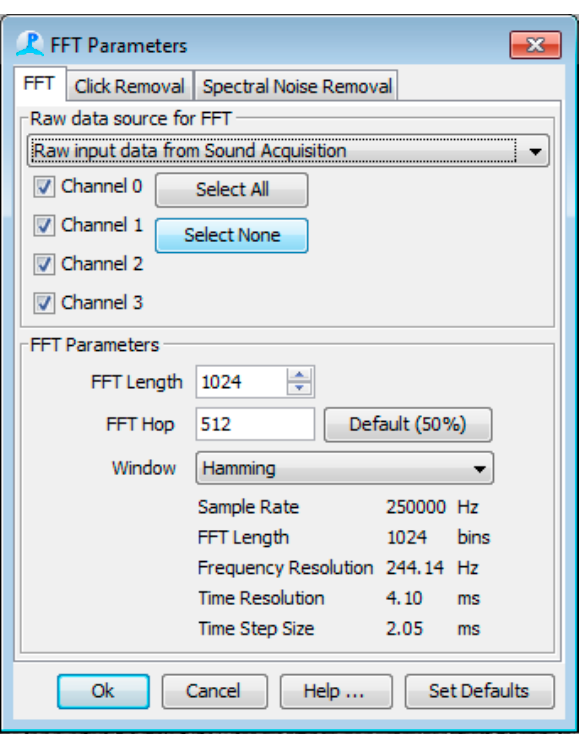
Figure 4. An example of the FFT Parameters module in PAMGuard. This module allows the user